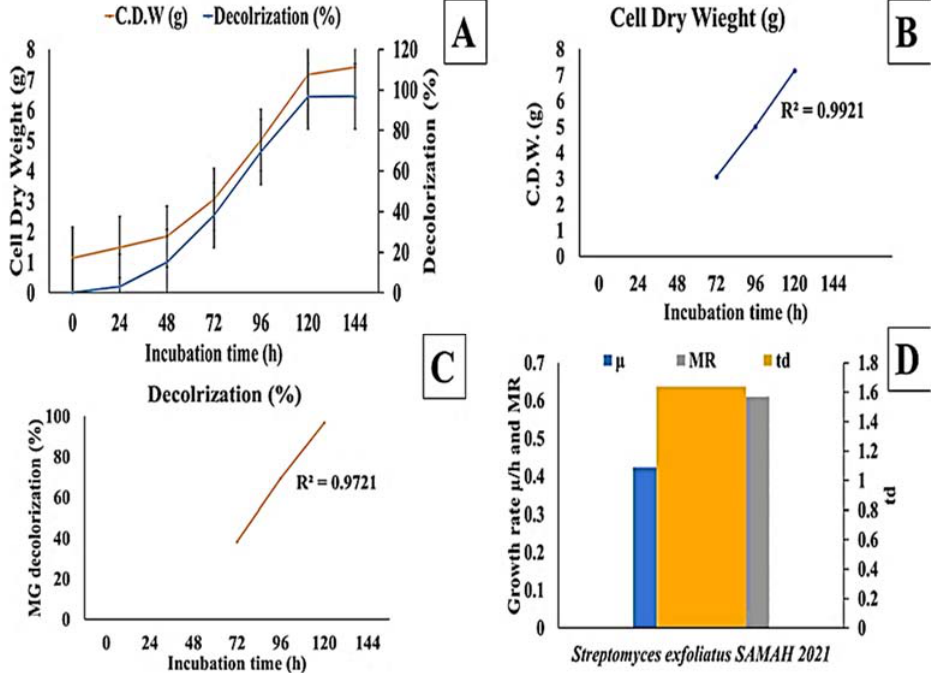
Figure 4. Effect of incubation time on MG degradation using S. exfoliatus incubated at 30 °C for 144 h. ( A ) decolorization (%) and dry cell weight (g) against time. ( B ) Cell dry weight (g) during the exponential phase of S. exfoliatus . ( C ) decolorization (%) during exponential phase of S. exfoliatus . ( D ) specific growth rate ( µ /h), multiplication rate (MR) and doubling time (td) during the exponential phase of S. exfoliatus .